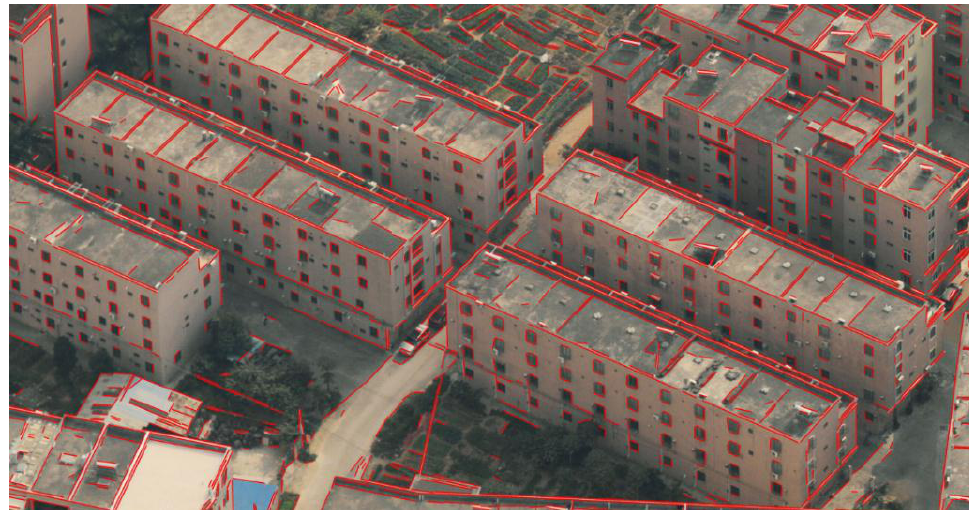
Figure 4. Line primitives extracted with the EDlines detector.